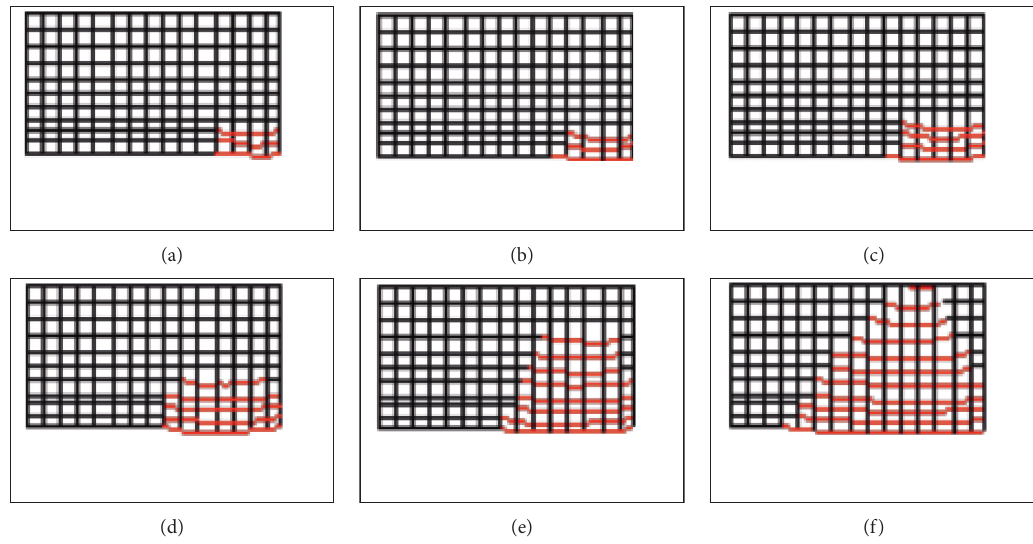
Figure 10: Subsidence map of measuring point with working face of scheme 3. (a) The first periodic pressure. (b) The second periodic pressure. (c) The third periodic pressure. (d) The fourth periodic pressure. (e) The fifth periodic pressure. (f) The eighth periodic pressure.